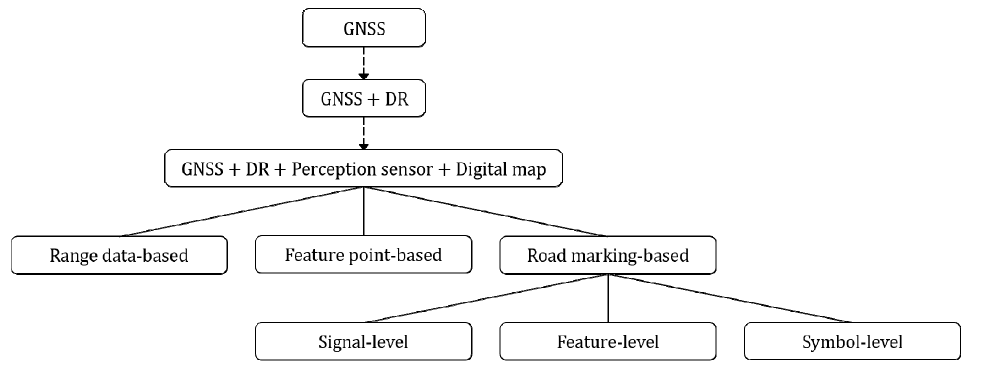
Figure 3. Taxonomy of vehicle localization methods.